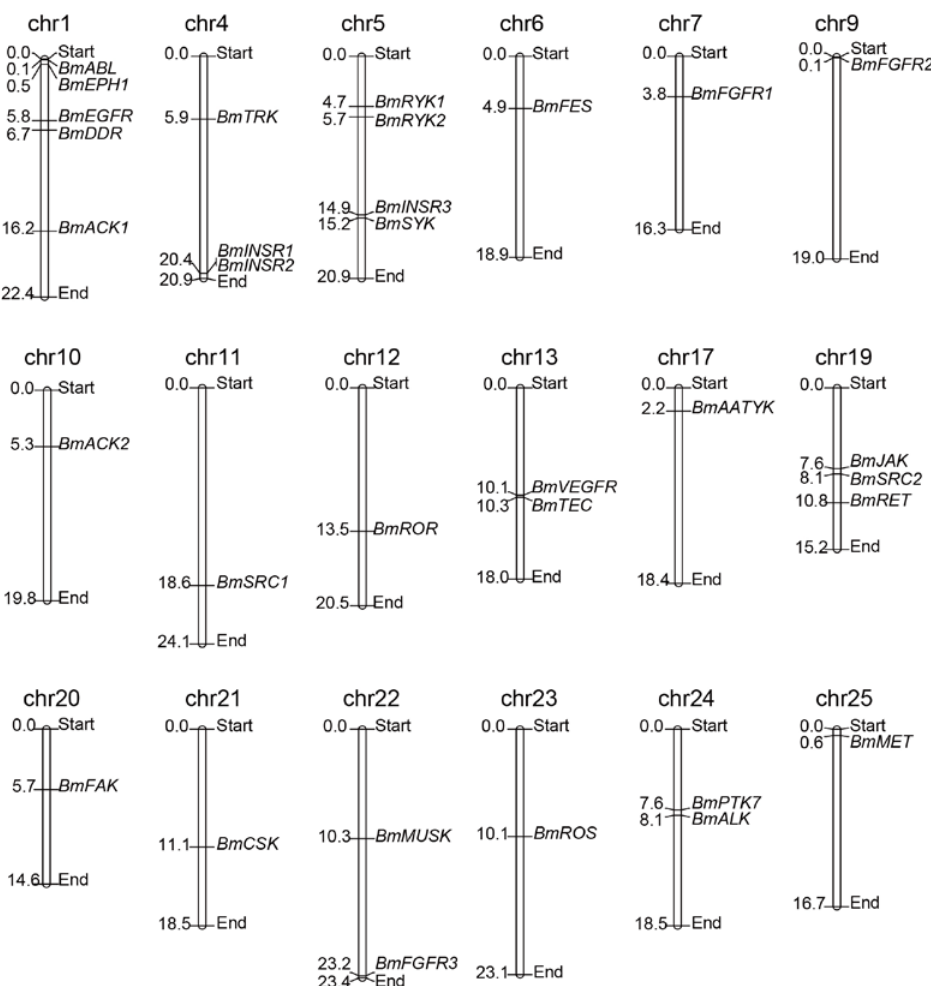
Figure 1. BmTKs distribution map on silkworm chromosomes. 32 of the identified silkworm TK genes (i.e., all except BmEPH2 ) were plotted onto chromosomes based on their physical coordinates. The chr indicates chromosome. Chromosomal distances are given in Mb (Mega base).